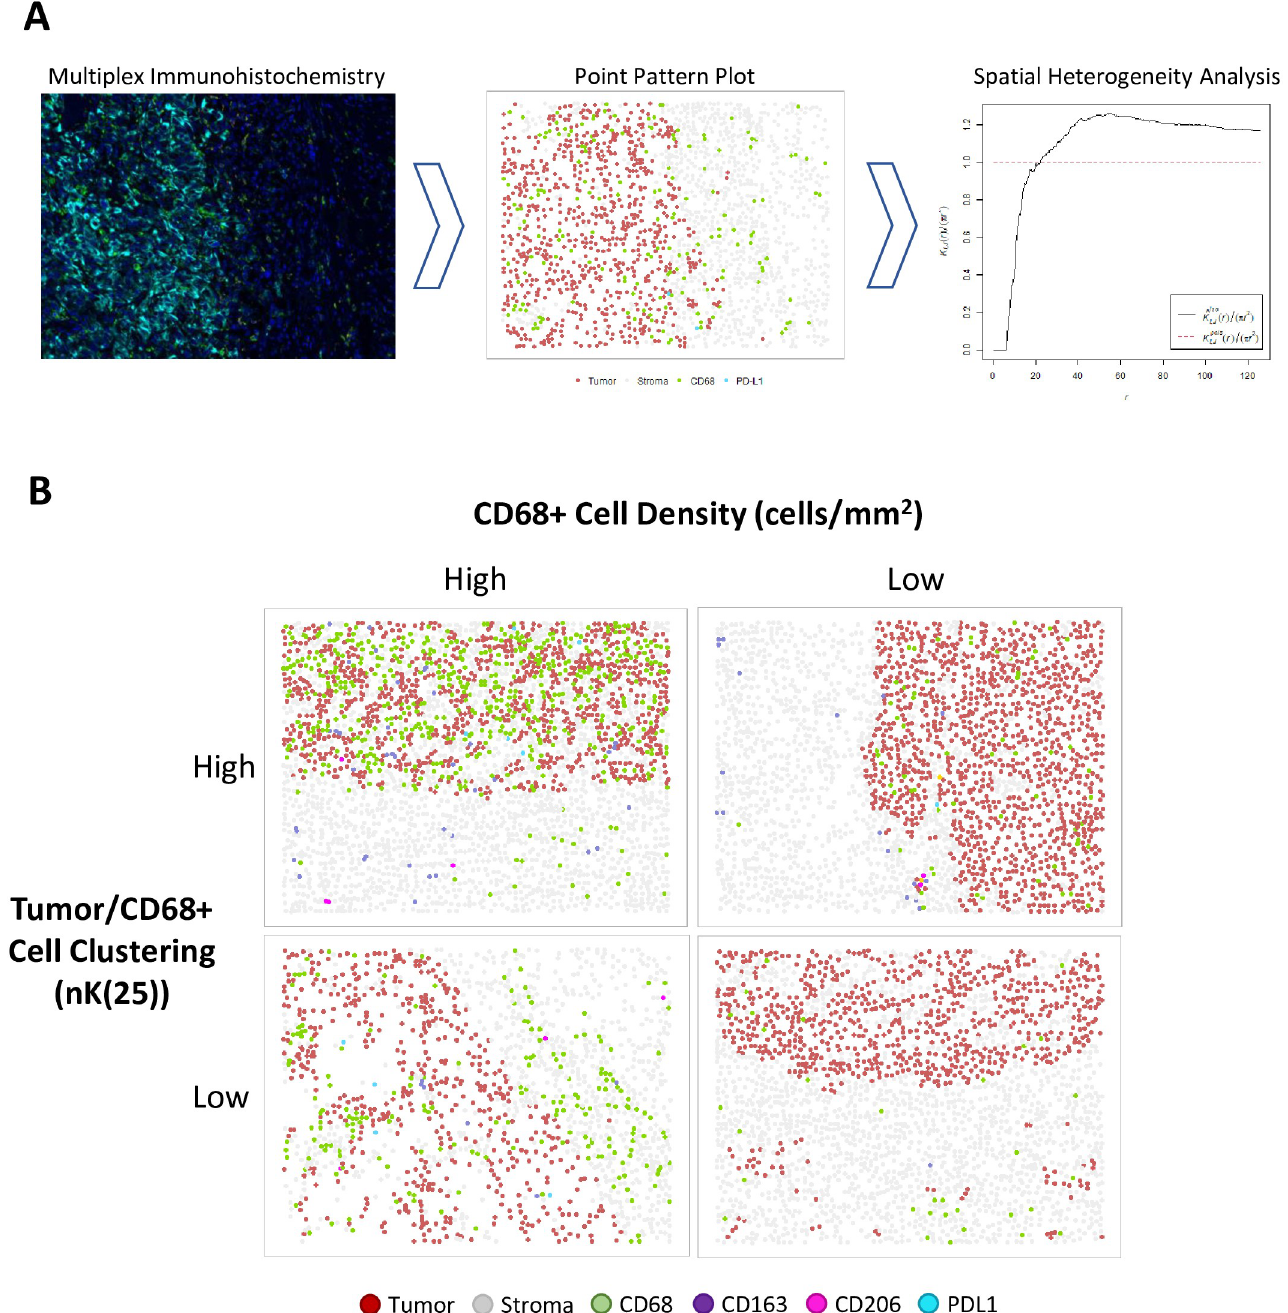
Fig 2. A: Project workflow, in brief. IHC staining for myeloid markers (CD68, CD163, CD206) and PD-L1. Digital pathologic analysis is utilized to convert IHC slides to point pattern plots, which are then utilized to calculate measures of spatial heterogeneity. B: Examples of point pattern plots demonstrating high or low CD68+ cell density (cells/mm2; cut-point = 151.273), and high or low Tumor/CD68+ cell clustering (nK(25), cut-point = 1.30).